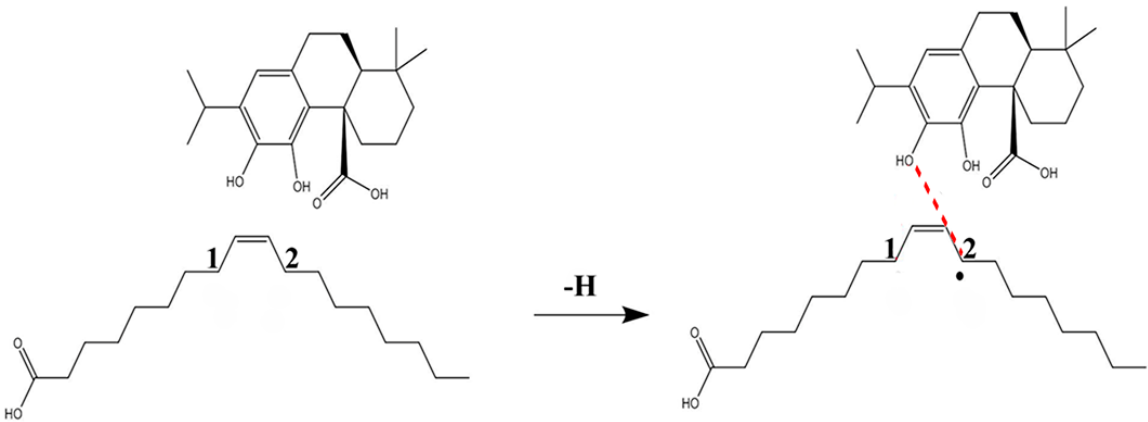
Figure 2. Reaction model of CA against the oxidation of OA (2#).